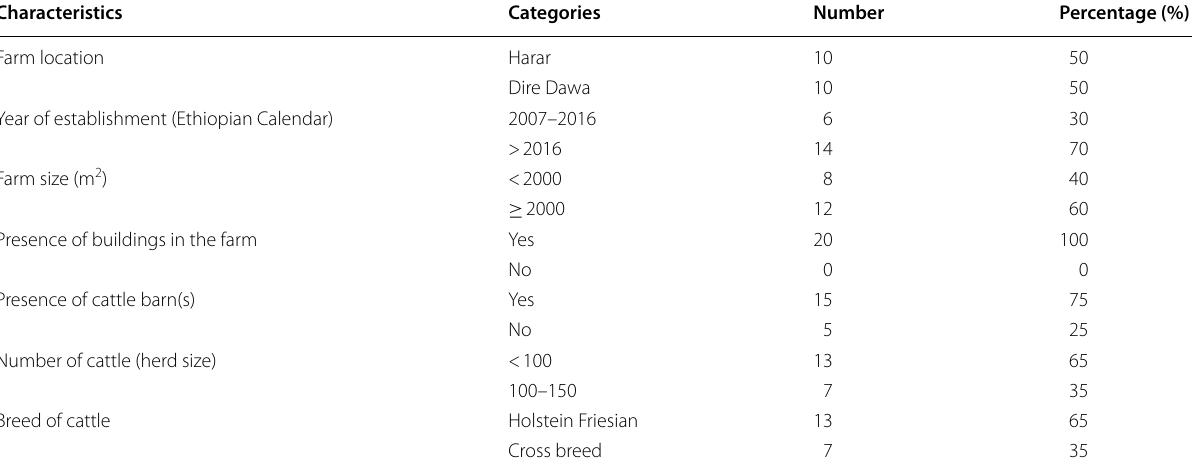
Table 1 Characteristics of dairy farms established in and around Harar and Dire Dawa cities Characteristics